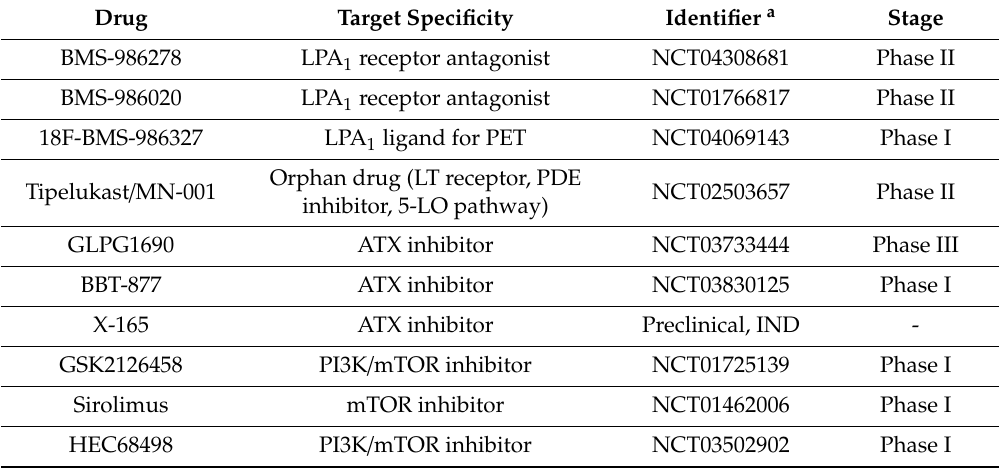
Table 1. Clinical studies to evaluate new drugs targeting lipid-mediated pathways in the treatment of pulmonary